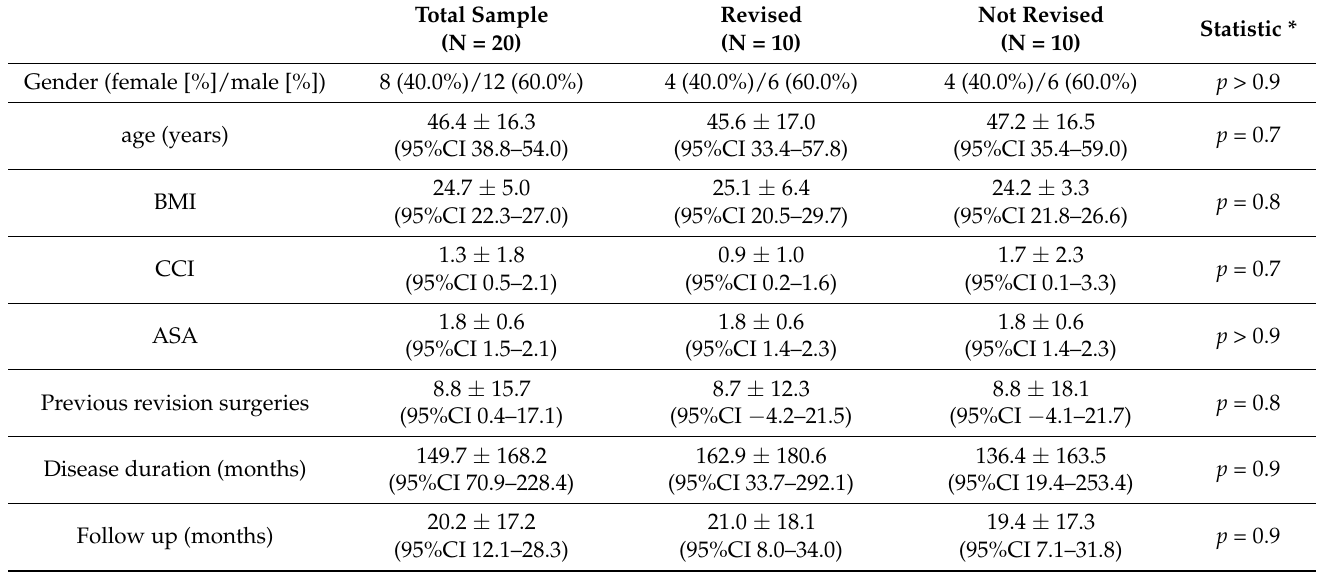
Table 1. Demographic overview of the study cohort.